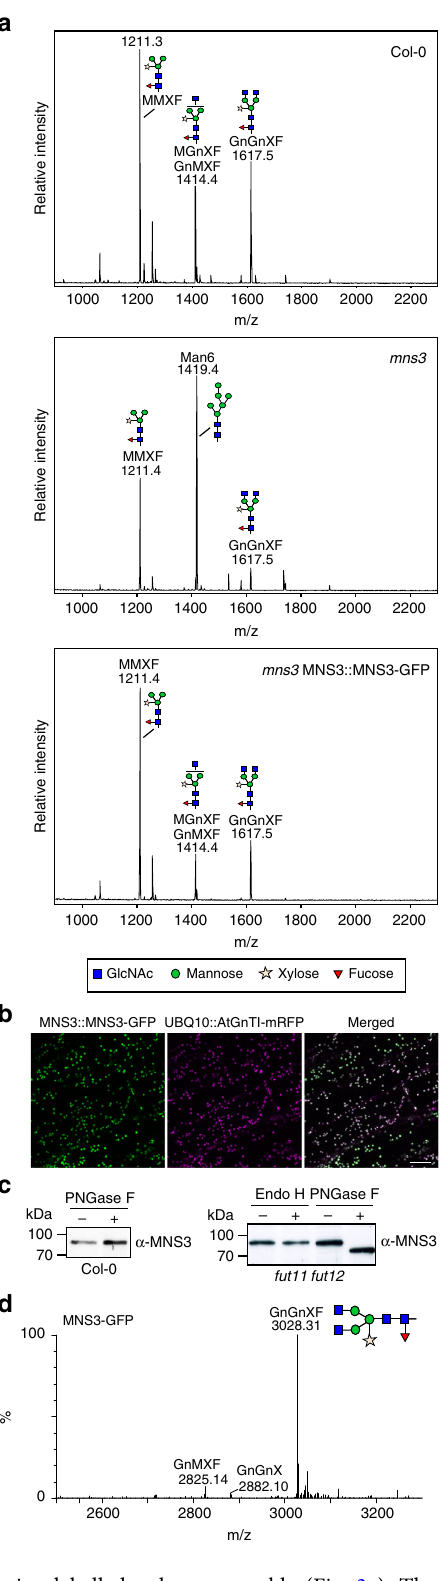
Fig. 2 MNS3 carries Golgi-processed complex N-glycans. a Matrix-assisted laser desorption ionization time-of- fl ight (MALDI-TOF) mass spectra of total N-glycans extracted from leaves of Arabidopsis wild-type (Col-0) plants, mns3 , and mns3 complemented with MNS3::MNS3-GFP. b Confocal images of transgenic Arabidopsis mns3 seedlings expressing MNS3::MNS3- GFP (green) crossed with gntI knockout plants expressing UBQ10::AtGnTI- mRFP 29 (magenta). Scale bar = 10 µ m. c Endo H and PNGase F digestion of crude protein extracts from Arabidopsis wild-type (Col-0) and mutant plants lacking core α 1,3-fucosyltransferase activity ( fut11 fut12 ). Proteins were separated by SDS-PAGE and blots were probed with an